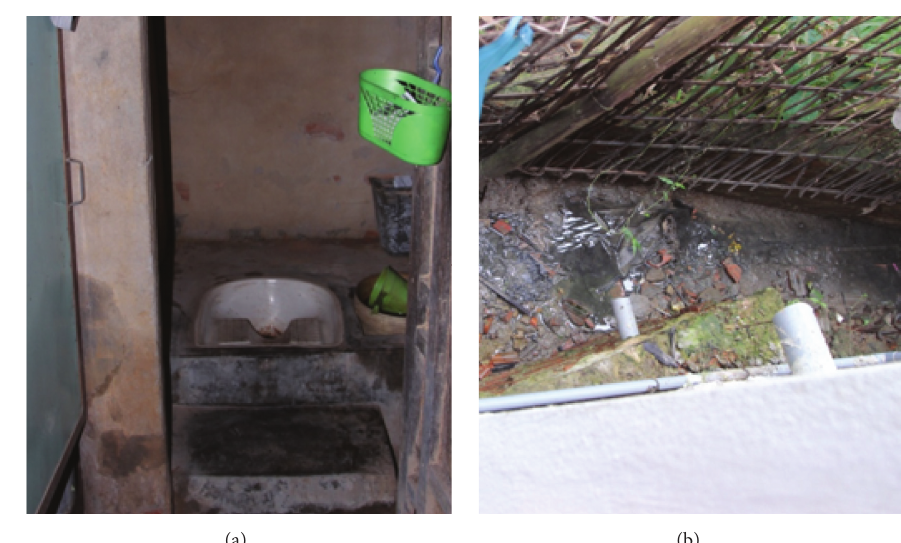
Figure 2: Typical household pour-flush pit latrine (a). Black water overflow and gray water discharged to backyard (b) (photo taken by